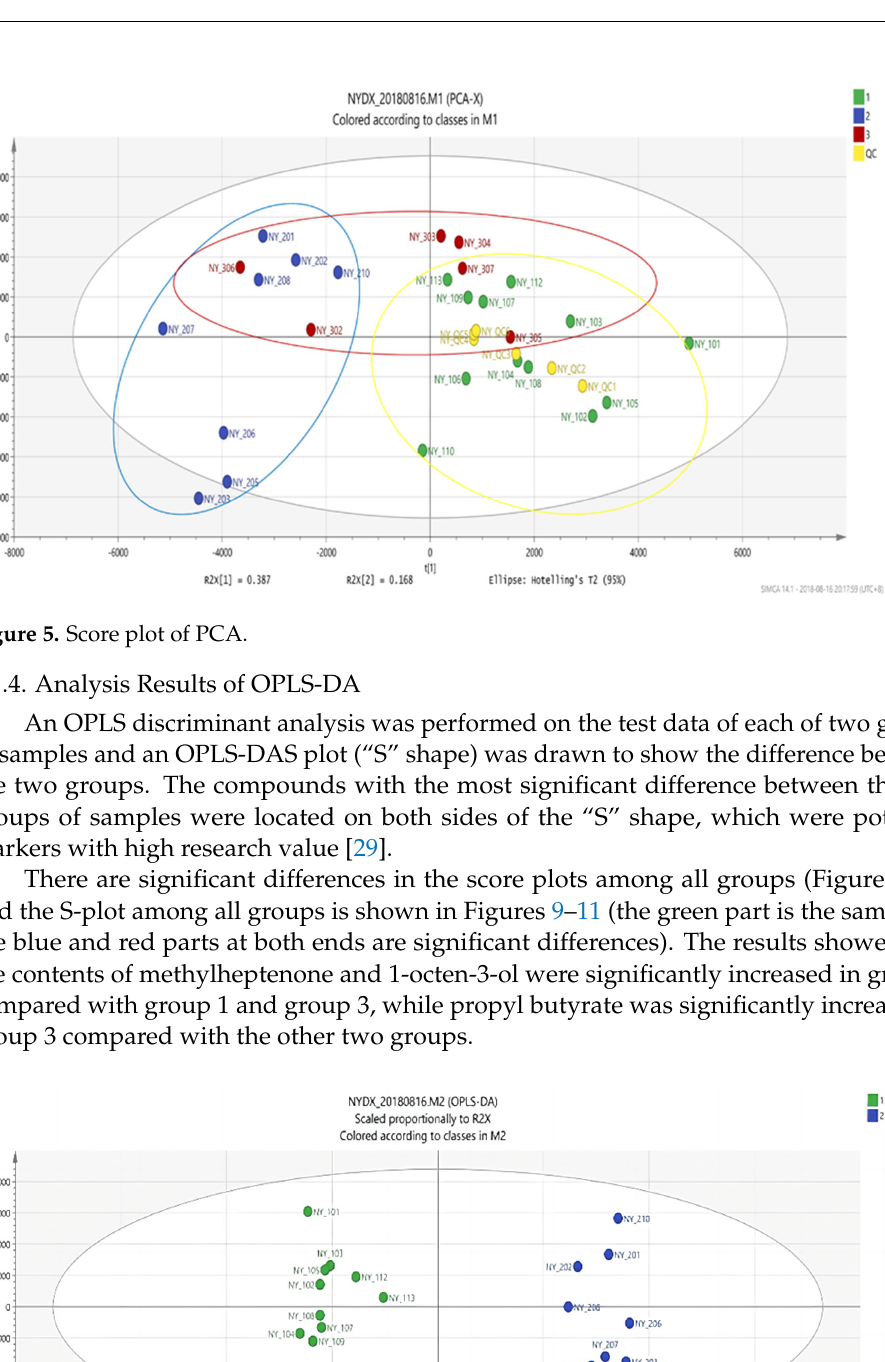
Figure 6. OPLS-DA score plots between group 1 and group 2.